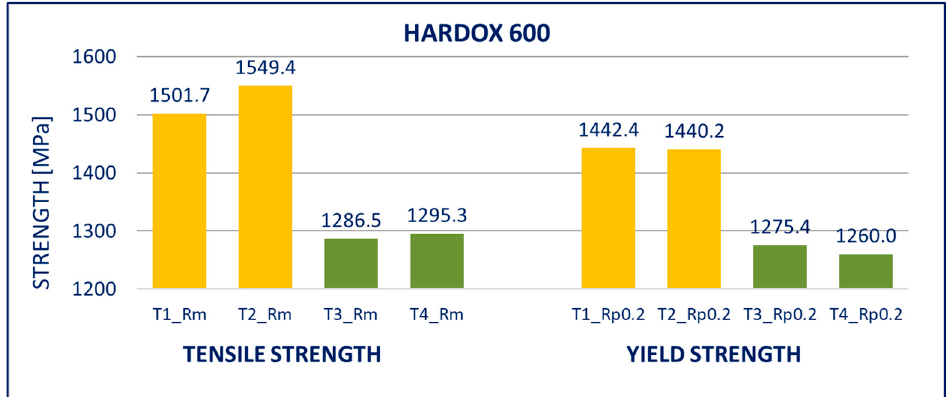
Figure 9. Tensile tests of specimens from HARDOX 600 steel. Description of specimens: T1 and T2 are groups of specimens without zinc coating; T3 and T4 are groups of specimens after hot-dip galvanization. R m is tensile strength, R p0.2 is yield strength.